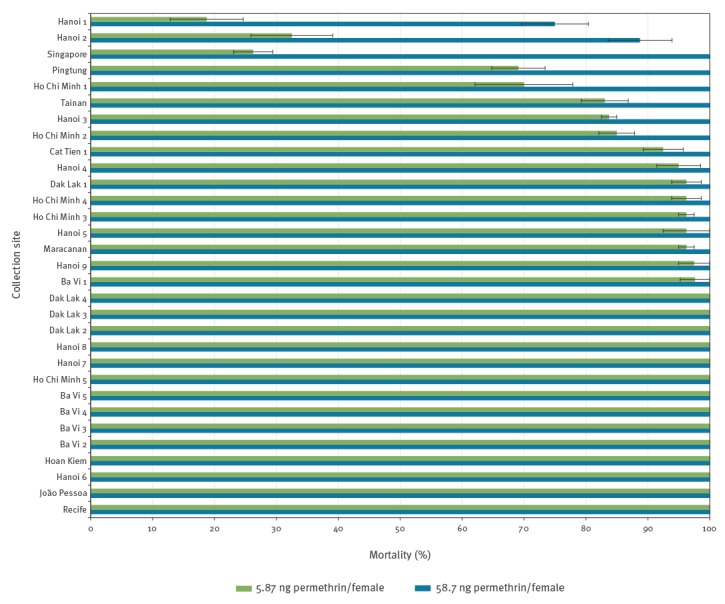
Mortalities of adult Aedes albopictus after exposures to permethrin, September 2015–June 2017 (n = 31 populations)a